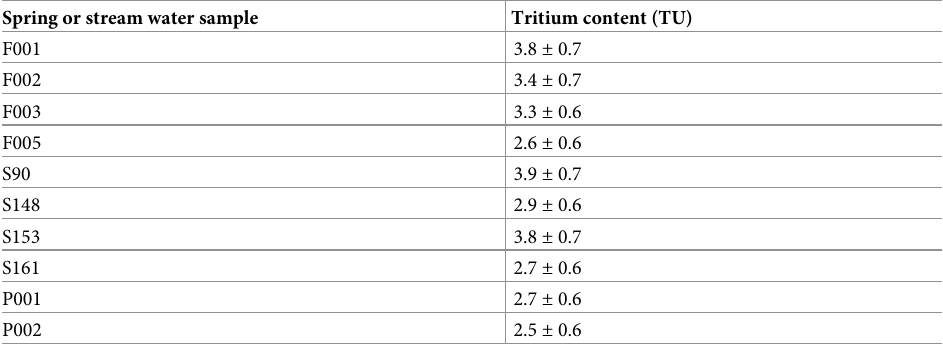
Table 4. Tritium content in spring and stream water